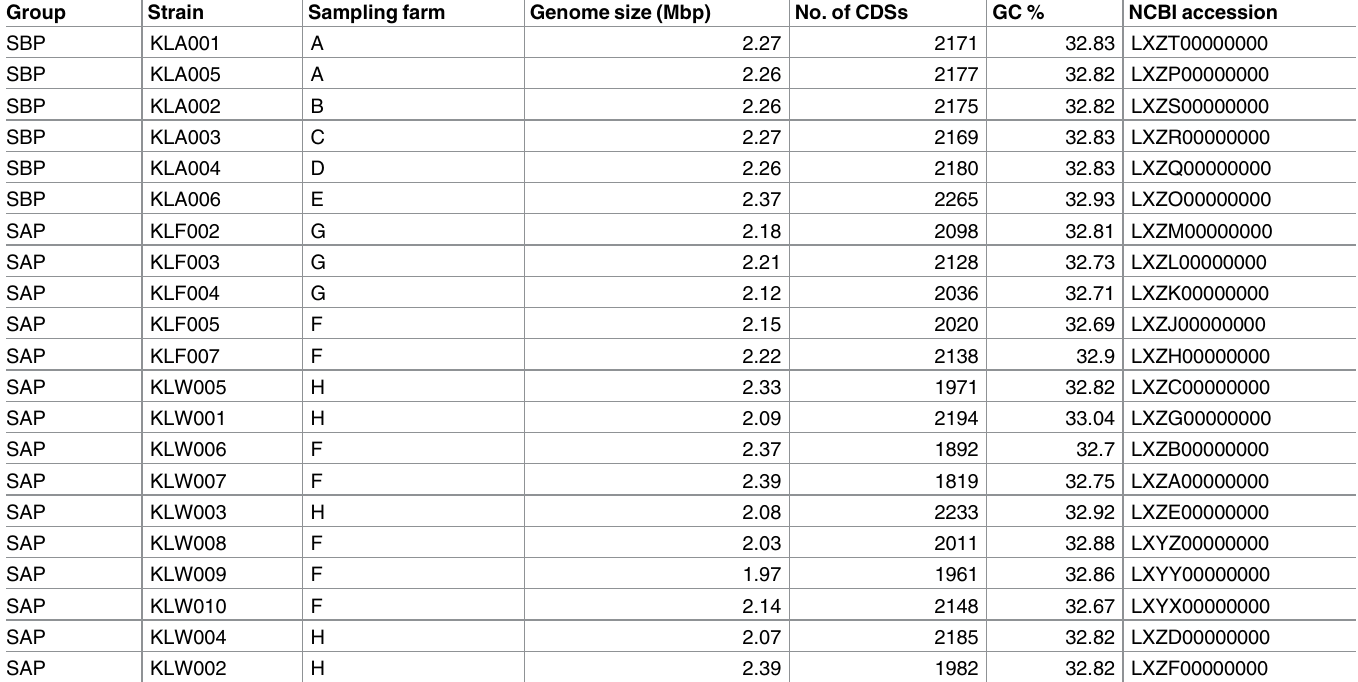
Table 1. Draft genomes used in this study.